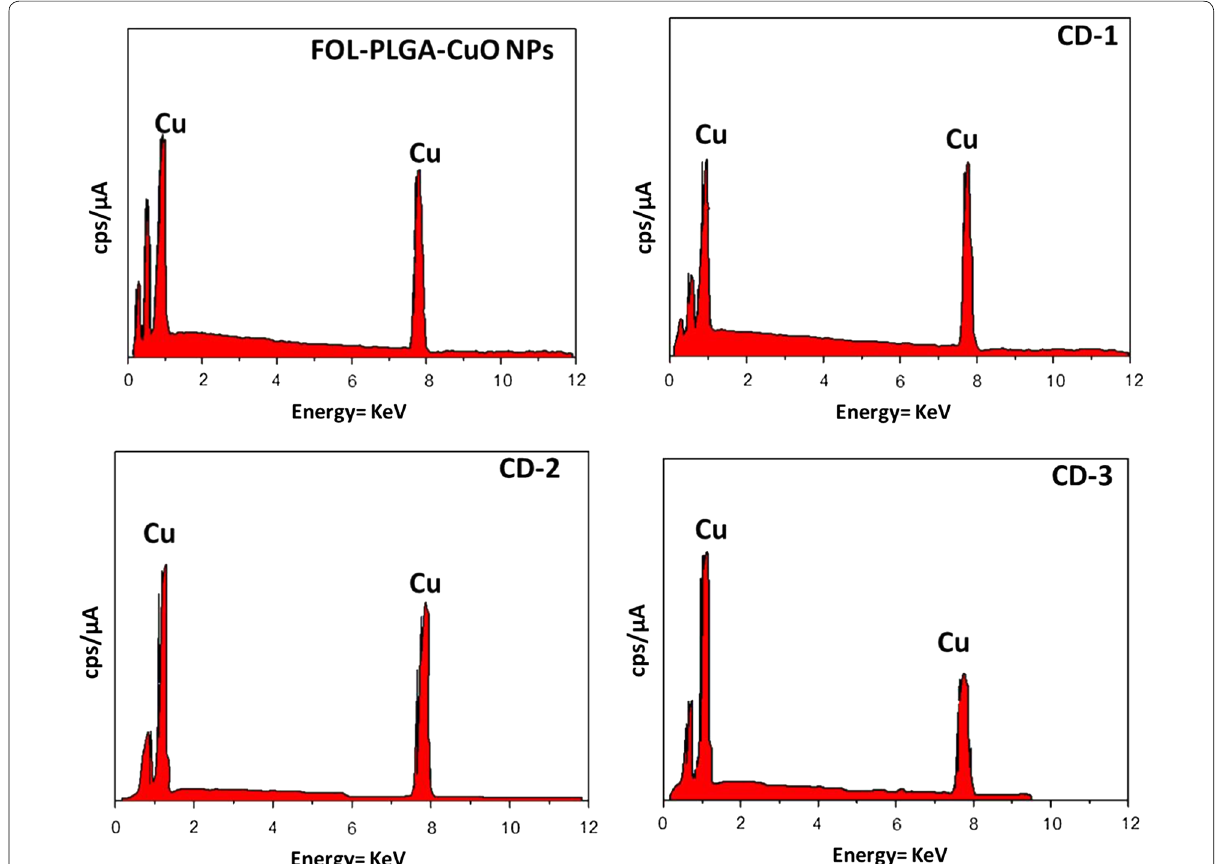
Fig. 2 Presence of elemental Cu in CuO NPs, FOL‑PLGA‑CuO NPs, CD‑1, CD‑2 and CD‑3. This indicates the incorporation of drugs in CuO